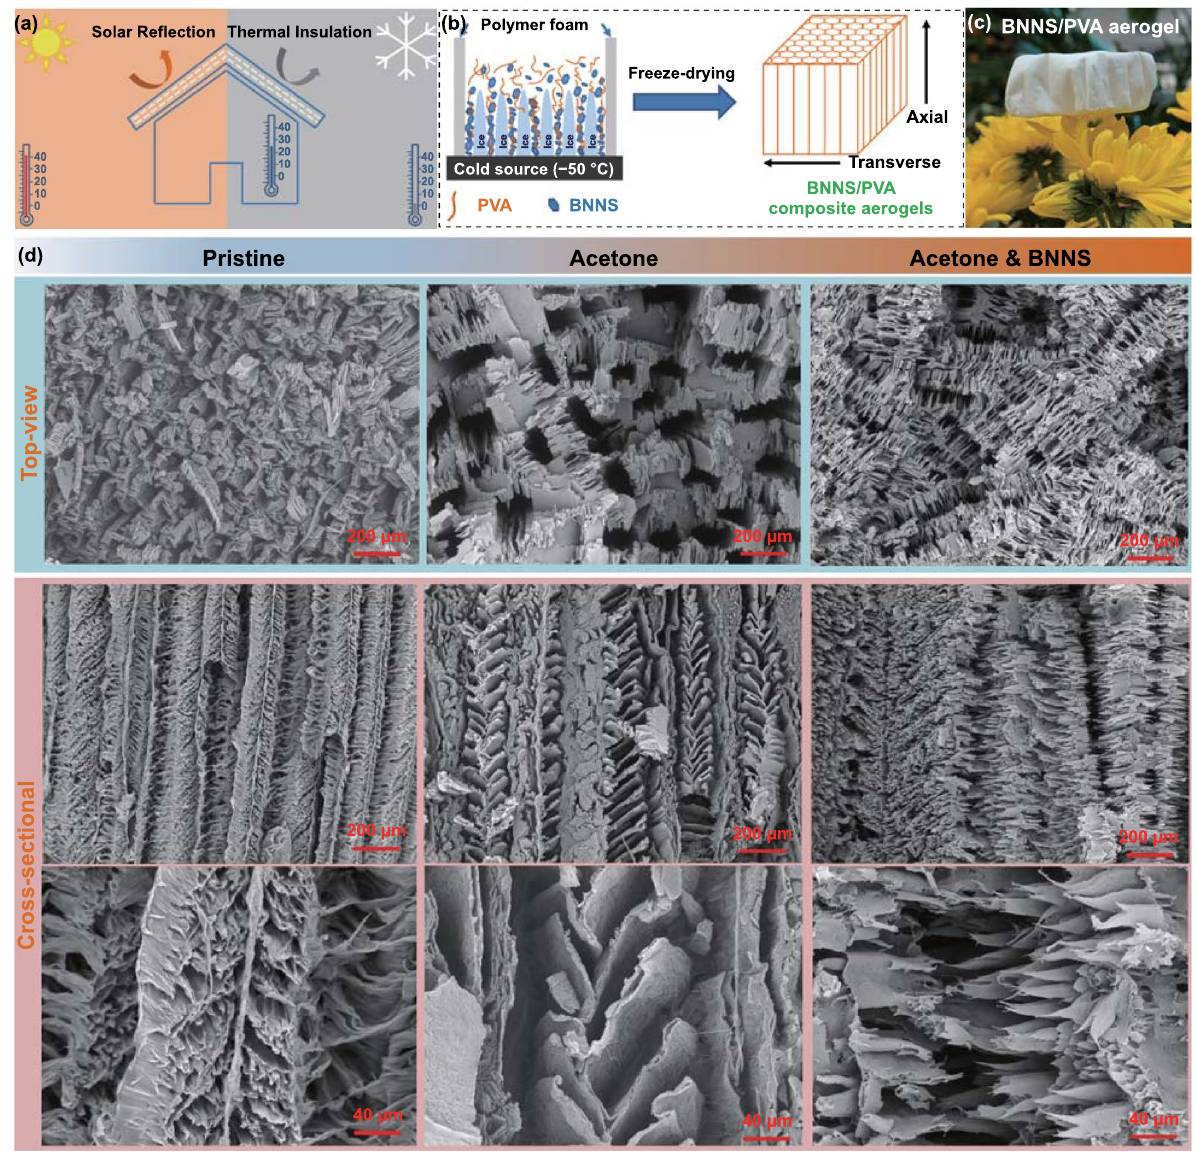
Fig. 1 Superinsulating solar‑reflective composite aerogels. a Schematic illustration showing the temperature regulation of the composite aero‑ gels capable of both thermal insulation and solar reflection for energy‑saving buildings. b Schematic illustration of the preparation of BNNS/ PVA composite aerogels with highly aligned channels through an acetone‑assisted unidirectional freezing method. c Digital photograph of light‑ weight BNNS/PVA composite aerogel standing on the petals. d SEM images showing microstructure evolution of the BNNS/PVA composite aerogels after adding acetone and